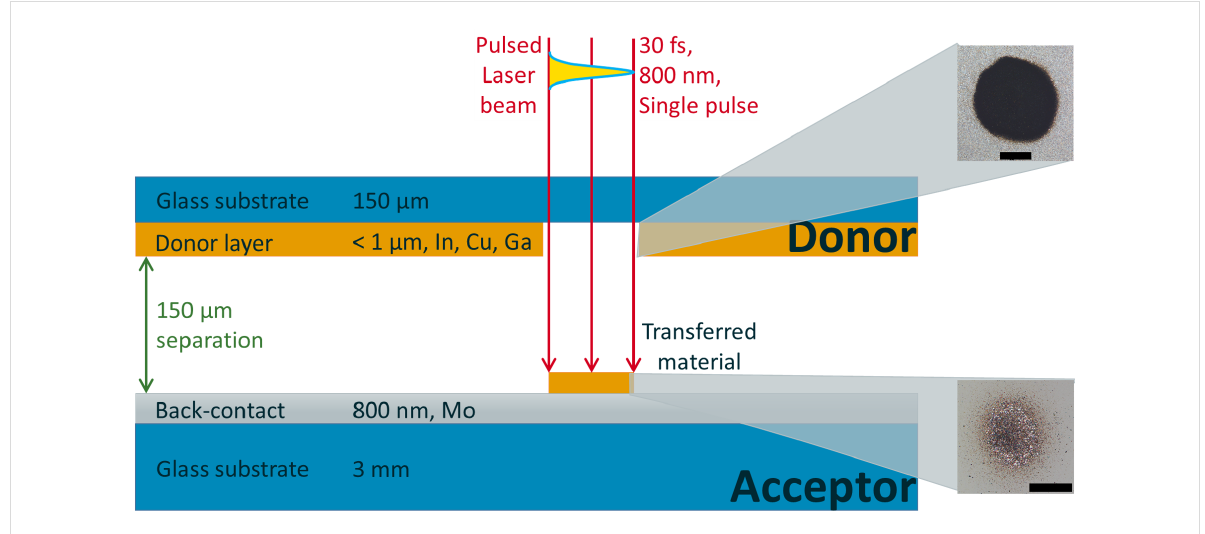
Figure 8: Scheme of laser-induced forward transfer. The scale bars in the OM insets on the right-hand side correspond to 50 µm. The OM pictures show the partial transfer of a 150 nm thick indium layer. Reprinted with permission from [22], copyright 2017 Springer Nature.